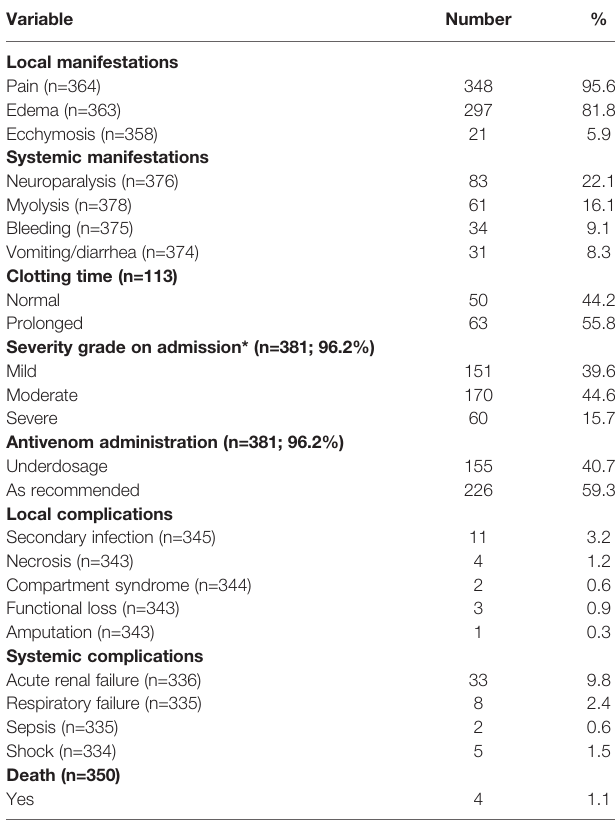
TABLE 3 | Clinical characteristics of C. d. ruruima envenomings reported in the state of Roraima, northern Brazilian Amazon, from 2010 to